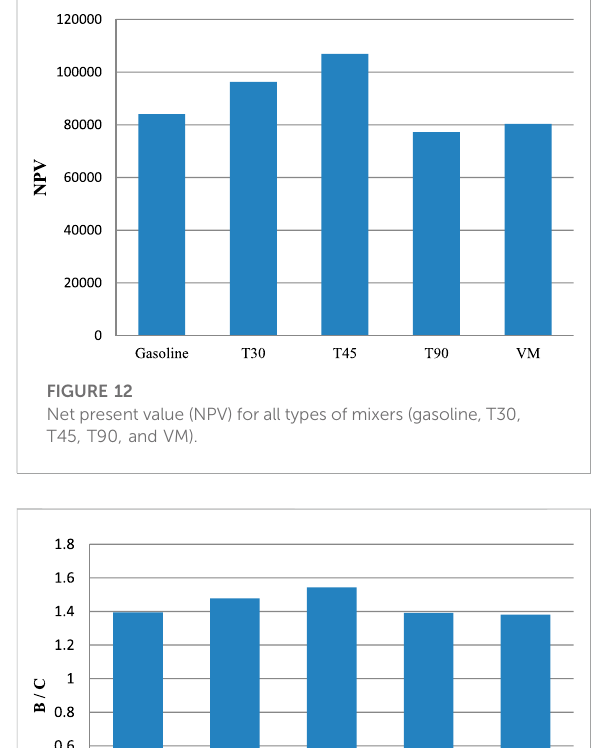
FIGURE 13 Bene fi t – cost ratio (B/C) for all types of mixers (gasoline, T30, T45, T90, and